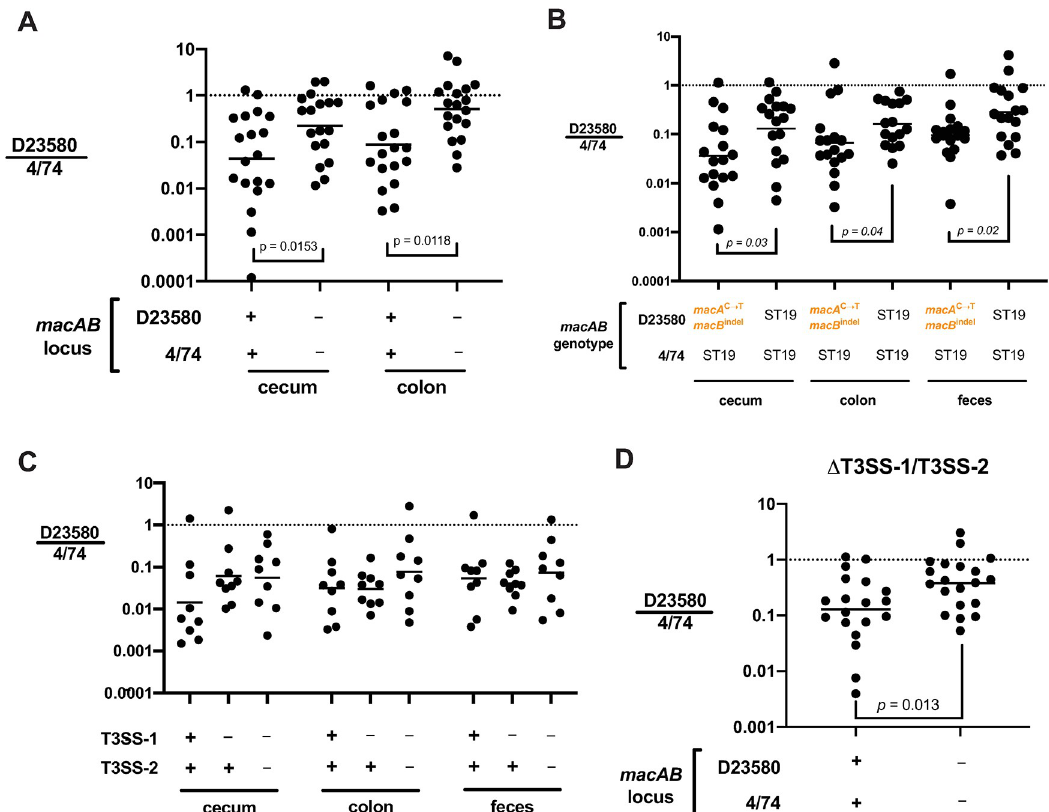
Fig 5. macAB influences fitness of S . Typhimurium D23580 in competition with 4/74 after oral infection. C57BL/6J mice ( Nramp1 -/- ) were orally gavaged with streptomycin one day prior to oral infection with 5x10 7 CFU each of a mixture of 4/74 and D23580 in PBS. Tissues were isolated for CFU determination and calculation of competitive index at day 2 after infection. (A) Competitive index of unmodified D23580 (“+”) versus unmodified 4/74 (“+”) compared to the competitive index of D23580 macAB null (“–”) versus 4/74 macAB null (“–”). (B) Competitive index values of 4/74 versus D23580, or 4/74 versus D23580 macA ST19 macB ST19 . Two-way repeated measures ANOVA on log-transformed data with Sidak’s post-test within organ, p- values as indicated in (A, B). (C) Competitive index of D23580 versus 4/74 and their T3SS-1 ( orgA null) or T3SS-1/2 ( orgA ssaV null) mutants. Two-way repeated measures ANOVA on log-transformed data with no significant differences in (C). (D) Competitive index of D23580 versus 4/74 T3SS-1/T3SS-2 mutants ( orgA ssaV null) compared to competition of T3SS-1/2 mutants with full deletions of macAB ( orgA ssaV macAB null) in each isolate. t -test on log-transformed data from the cecum in (D). Dots are competitive index values for individual mice with lines plotted at the geometric mean. See S1 Fig for CFU/g values. SPI-2-induced inflammation in the gut to outcompete D23580. Accordingly, we competed 4/74 and D23580 strains that lacked T3SS-1 ( orgA null mutants) or T3SS-1/T3SS-2 ( orgA ssaV null mutants). The competitive advantage of 4/74 over D23580 was not dependent upon the pres- ence of T3SS-1 or T3SS-1/2 to induce gut inflammation (Fig 5C). However, there was a signifi- cant ~2.9-fold improvement in relative fitness of D23580 orgA ssaV macAB null versus 4/74 orgA ssaV macAB null mutants in the cecum compared to their orgAssaV null mutants with unmodified macAB (Fig 5D). These data demonstrate that macAB can influence relative fitness of D23580 versus 4/74 in the gut in the absence of T3SS-1/T3SS-2 induced inflammation. Host genetics shape the utility of macAB genotypes for D23580 systemic infection Since we saw no impact of the ST19 macAB genotype on D23580 replication in RAW264.7 cells, we predicted that ST313 macAB -associated SNPs might be dispensable or otherwise have